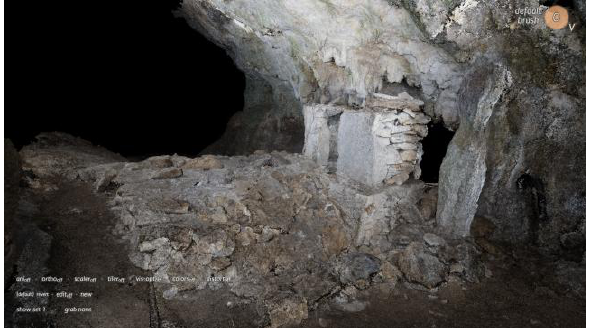
Figure 7. Point cloud (via SfM photogrammetry) of cave shrine X-2. Note the un-plastered sidewalls (similar to